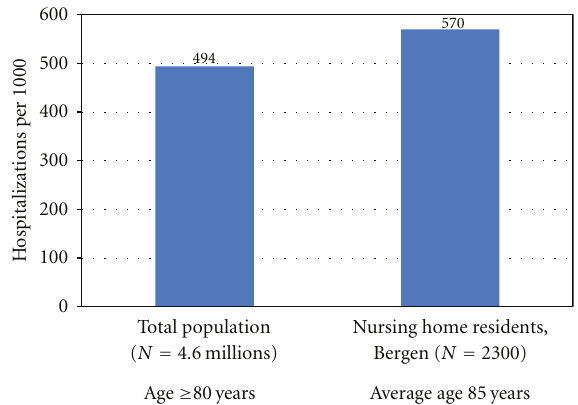
Figure 3: Hospitalization rates (per 1000 inhabitants/residents) for total Norway ( N = 4 . 6millions, age ≥ 80 years) and among nursing home patients ( N = 2300, long- and short-term, average age appr. 85 years), 2007, in Bergen, Norway. (Source: Statistics Norway). represents 62.5% of the total hospital responsibilities.